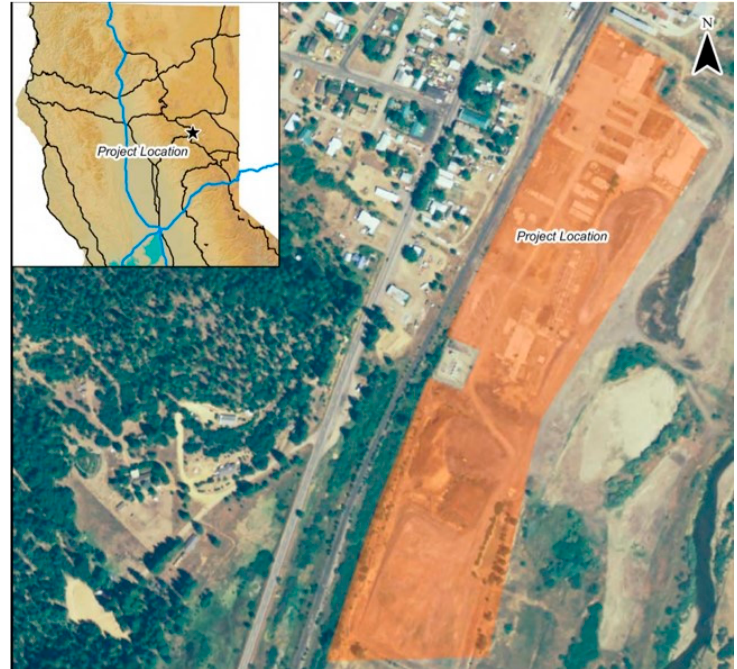
Figure 2. Map of Crescent Mills Campus in Northeastern California (photo credit: Sierra Institute for Community and Environment).